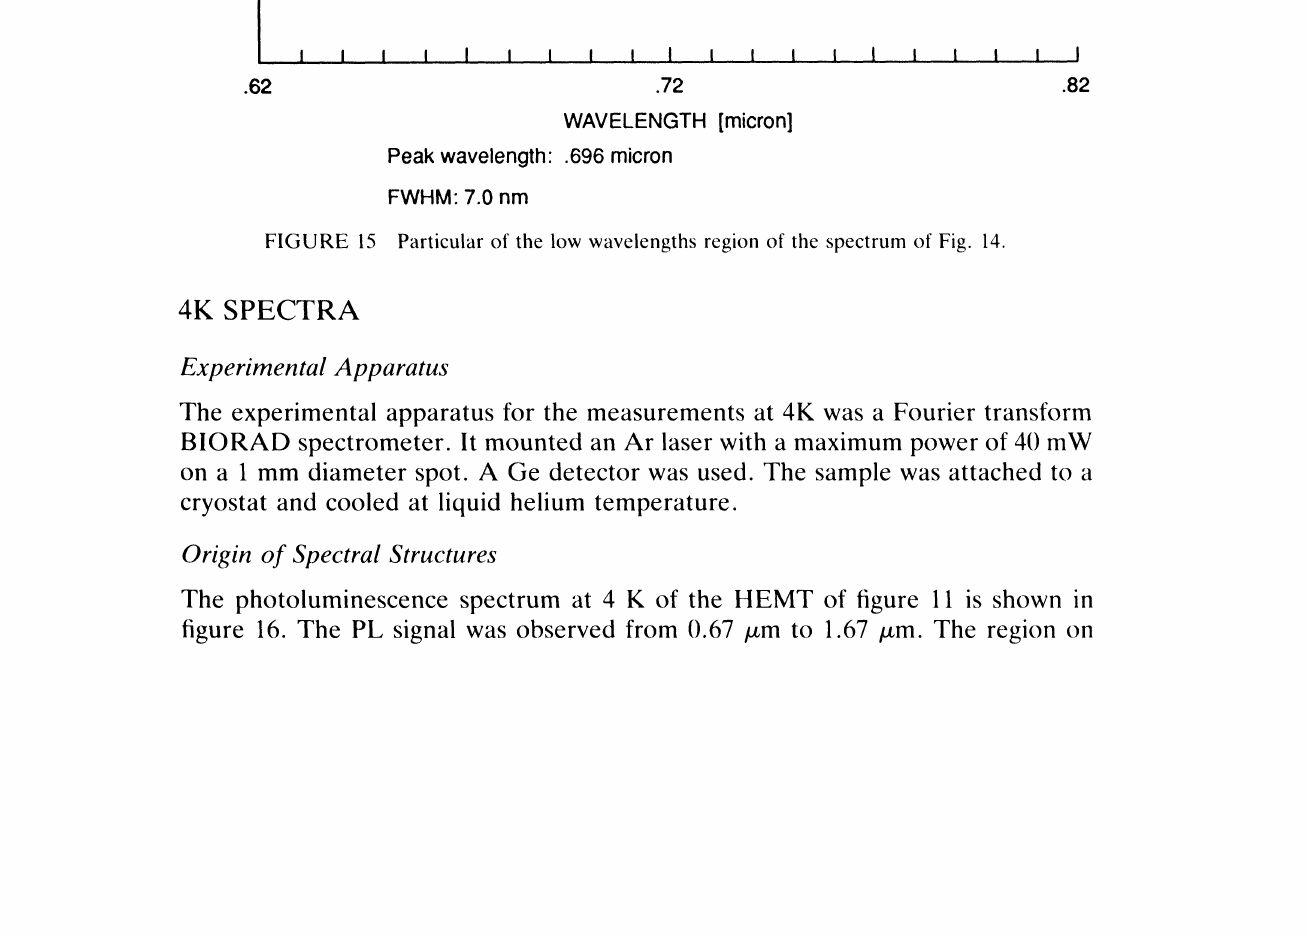
.72 WAVELENGTH [micron] Peak wavelength" .696 micron FWHM: 7.0 nm Particular of the low wavelengths region of the spectrum of Fig.